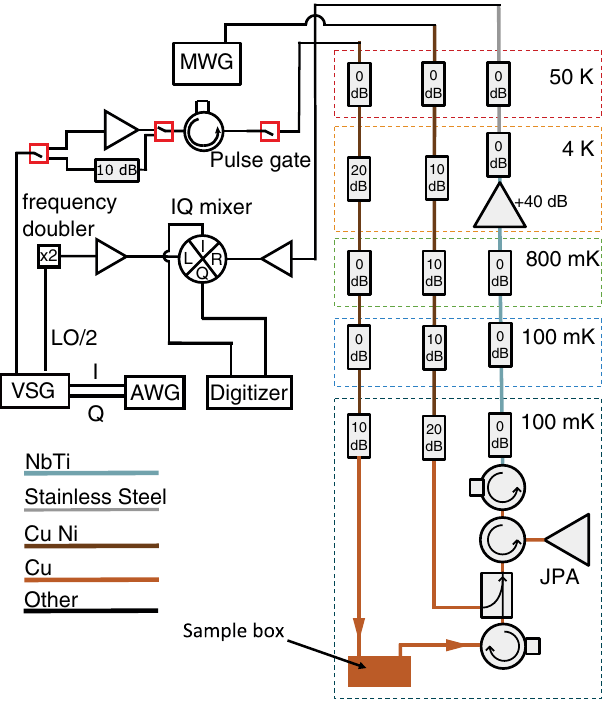
FIG. 8. Schematic of the spectrometer and dilution fridge setup. Microwave pulse signals are generated using a vector signal generator (VSG) and an arbitrary waveform generator (AWG). A microwave generator (MWG) is used to drive the Josephson parametric amplifier (JPA). The return signals are down-converted and detected with a digitizer. A signal at half the up-conversion local oscillator (LO) frequency provided by the VSG is doubled with a frequency doubler and used for down-conversion. Coaxial cable types inside the fridge have been color